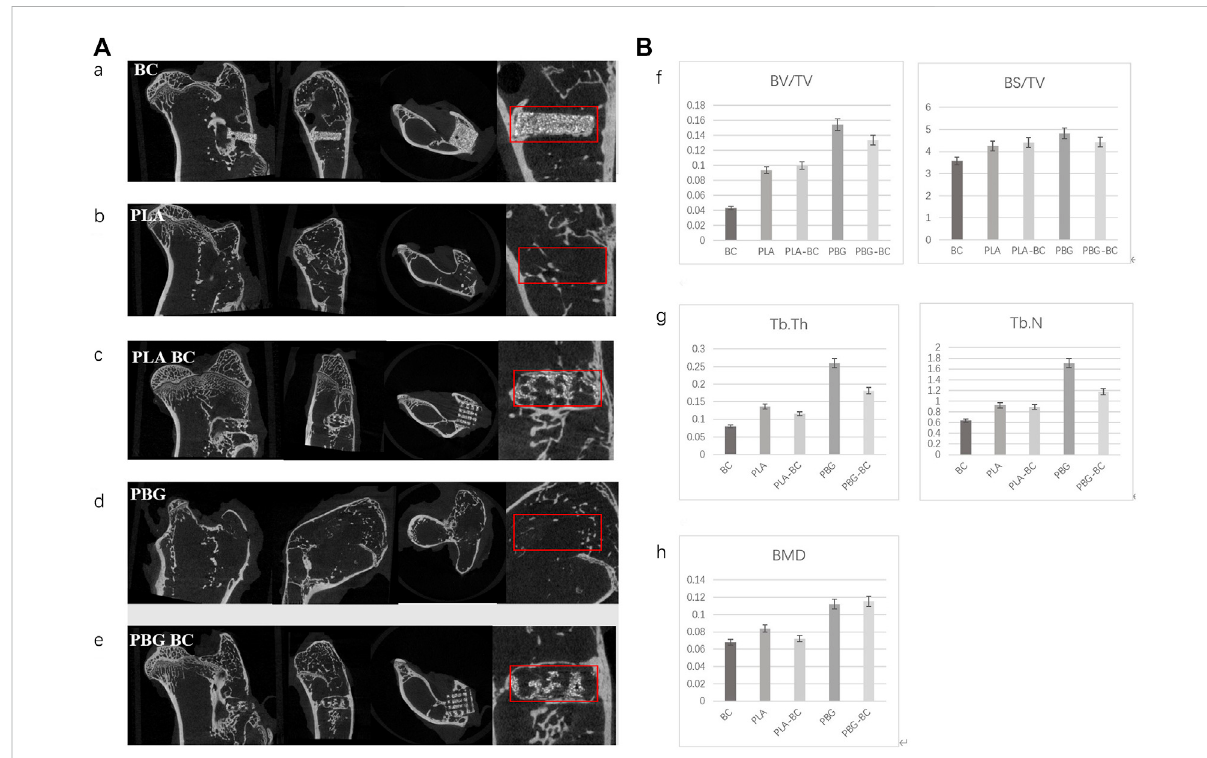
FIGURE 13 (A) . Coronal, sagittal, cross-sectional, and local enlarged images of micro-CT 4 weeks after sample implantation. a: BC, b: PLA, c: PLA-BC; d: PBG; e: PBG-BC. (B) . Statistical comparative analysis of local area (2 mm × 2 mm × 1 mm around the stent) of micro-CT 4 weeks after sample implantation.fbonevolume/tissuevolume(BV/TV),bonesurfacearea/tissuevolume(BS/TV);g:trabecularthickness(TB.Th),trabecularnumber(TB. N); h: bone mineral density (BMD). *: p <